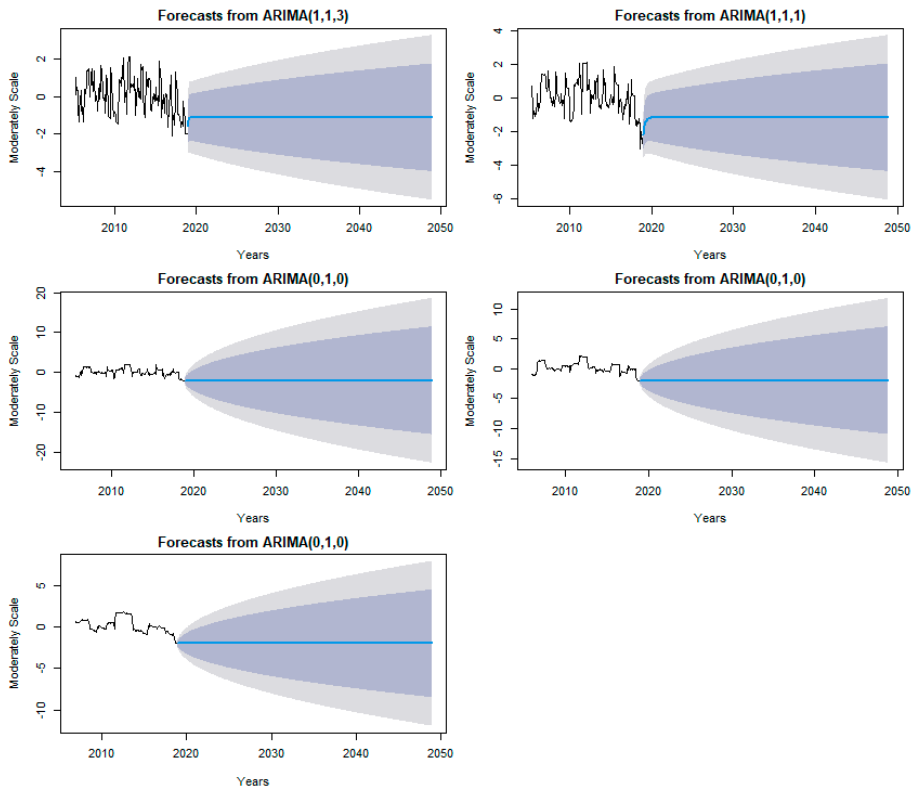
Figure 10. The long-term projection of SPEI for 30 years. Table 15. Point forecasted value of SPEI-3 for five years.